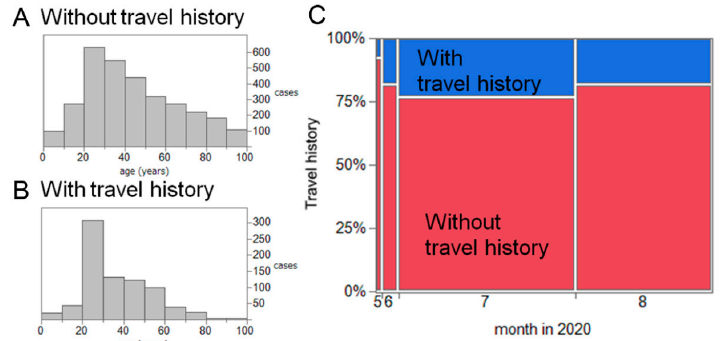
Figure 1. Age and time distributions for confirmed cases ( n = 3978) of coronavirus disease 2019 (COVID-19) in 24 prefectures of Japan with consistent reporting of travel history from 1 May to 31 August 2020. ( A , B ). Age distribution of cases with and without travel history information ( n = 3161 and n = 817, respectively). ( C ). Monthly count of confirmed cases, by travel history. Colored areas depict corresponding relative frequencies of cases.